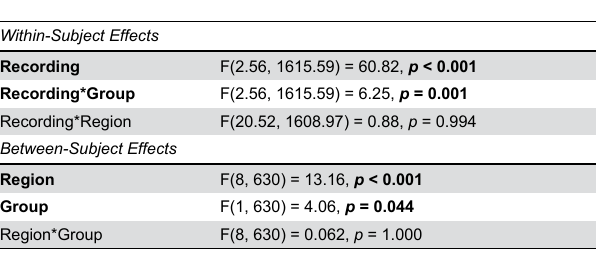
Table 2. Results from a repeated-measures ANOVA exploring the relationship between alpha power, EEG recording, region and